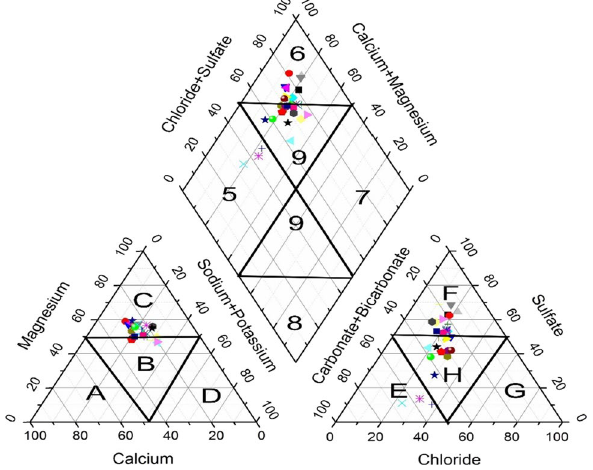
Fig. 8 Piper plot of water samples for premonsoon